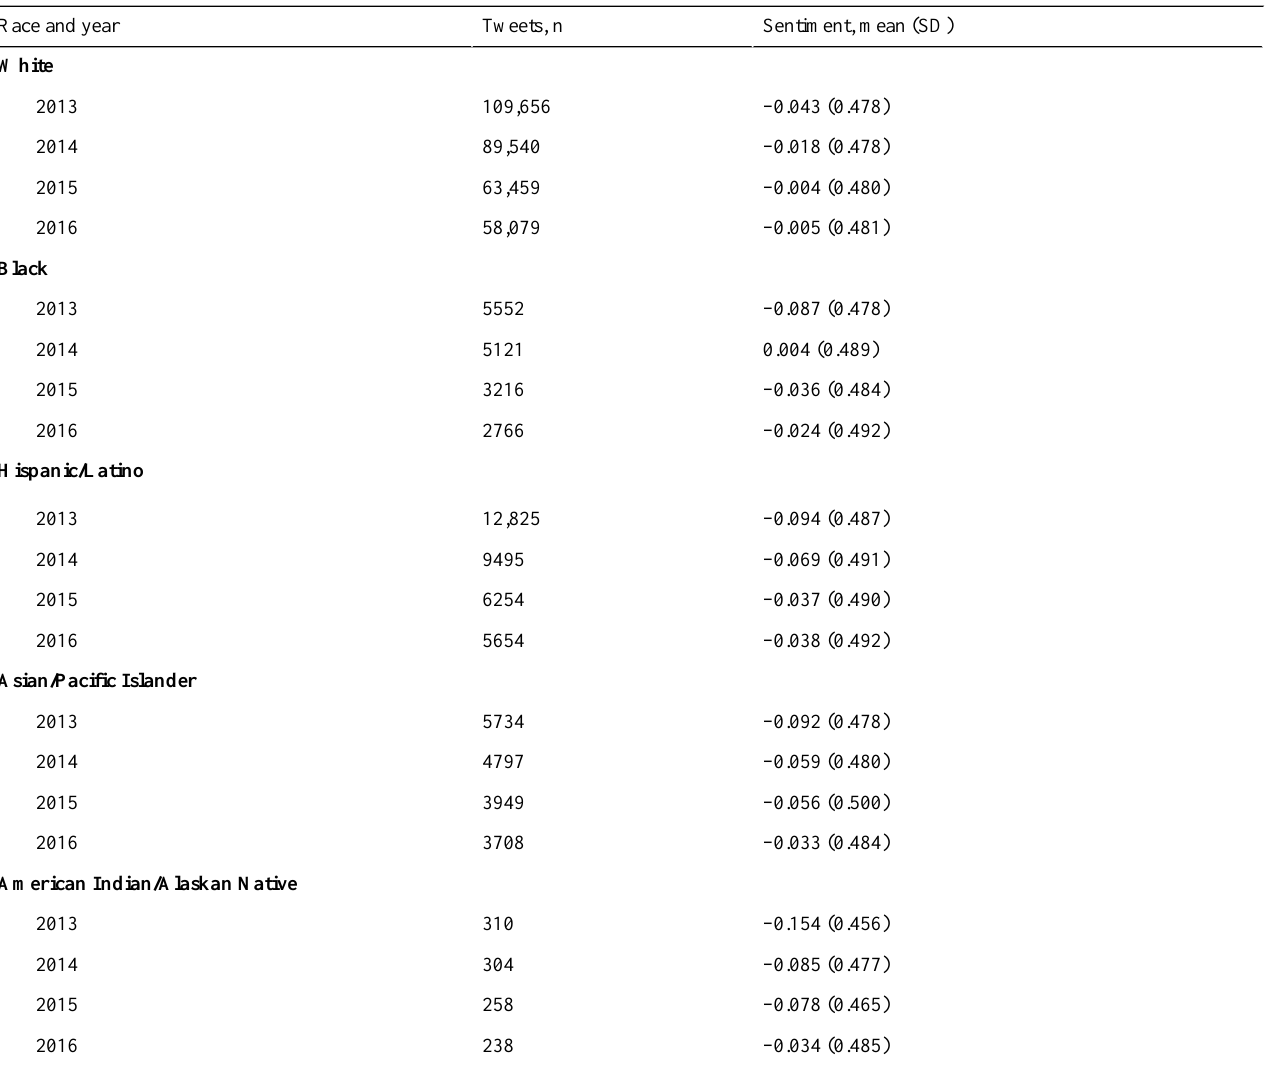
Table 1. Patient experience sentiment raw scores by racial and ethnic group from 2013 to 2016.